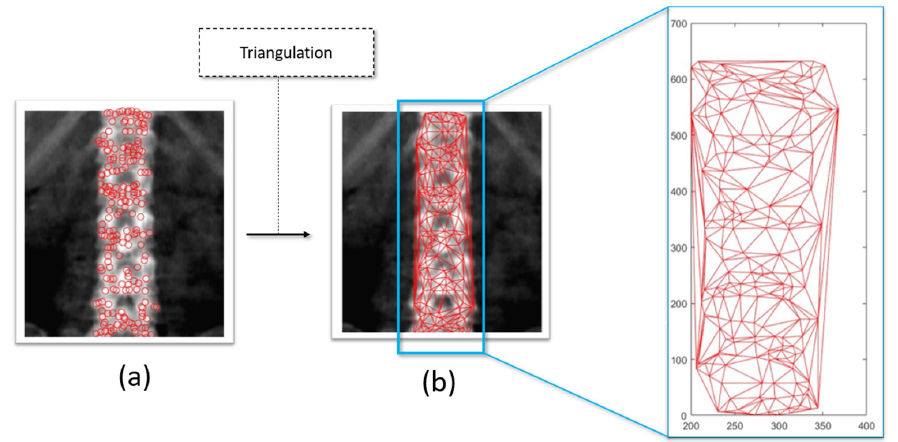
Figure 7. ( a ) SURF features plot and ( b ) Delaunay triangulation.